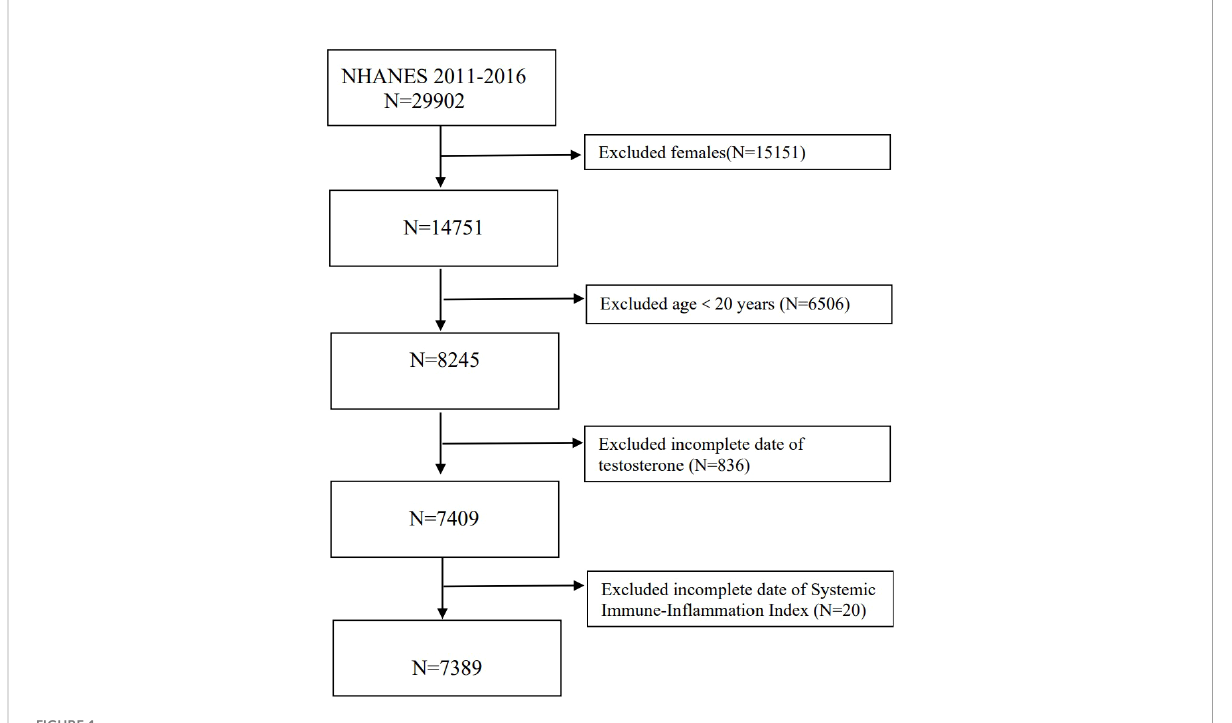
FIGURE 1 The selection process of NHANES